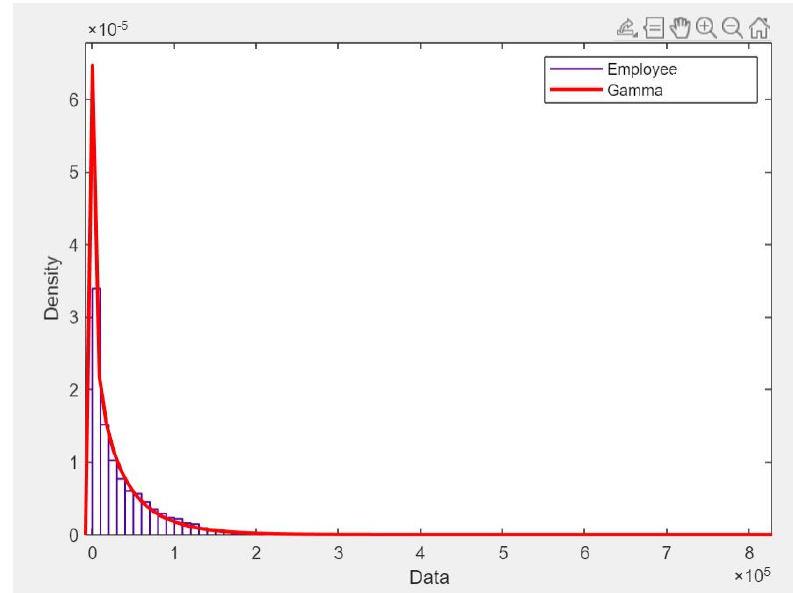
Figure 4. Probability distribution model for employees insurance